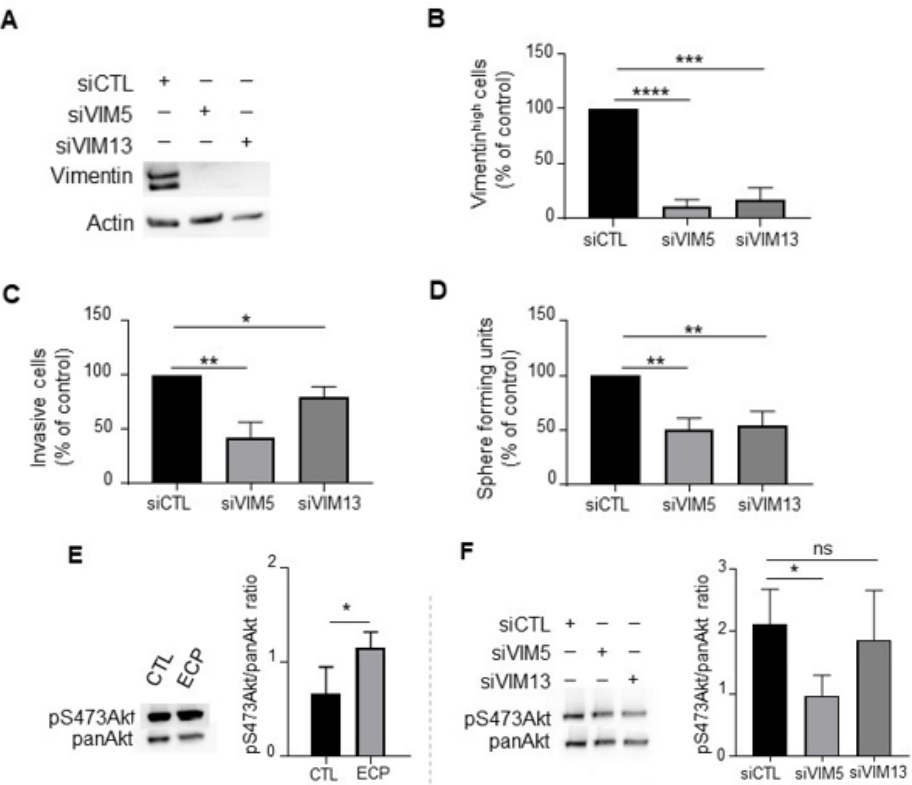
Figure 5. Effects of vimentin silencing on invasion, sphere formation and Akt phosphorylation in MDA-MB-231 persistent cells. Four days after ECP treatment, MDA-MB-231 persistent cells were seeded and cultured for 24 h before transfection with 2 sequences of siRNA targeting vimentin (VIM5, VIM13). Three days after transfection, vimentin levels were determined by Western blotting ( A ), or flow cytometry analysis to quantify vimentin high sub-population ( B ). Cells with fluorescence intensity ≥ log 10 3 were considered as vimentin high . ( C ) Effect of vimentin silencing on invasion of persistent cells. Three days after transfection with siRNA against vimentin , MDA-MB-231 persistent cells were seeded in the top of Boyden microchambers precoated with Matrigel. Invasive cells were counted following 24 h of culture. ( D ) Effect of vimentin silencing on sphere formation of persistent cells. Three days after transfection with siRNA against vimentin , MDA-MB-231 persistent cells were cultured in suspension in defined medium as described in materials and methods. The number